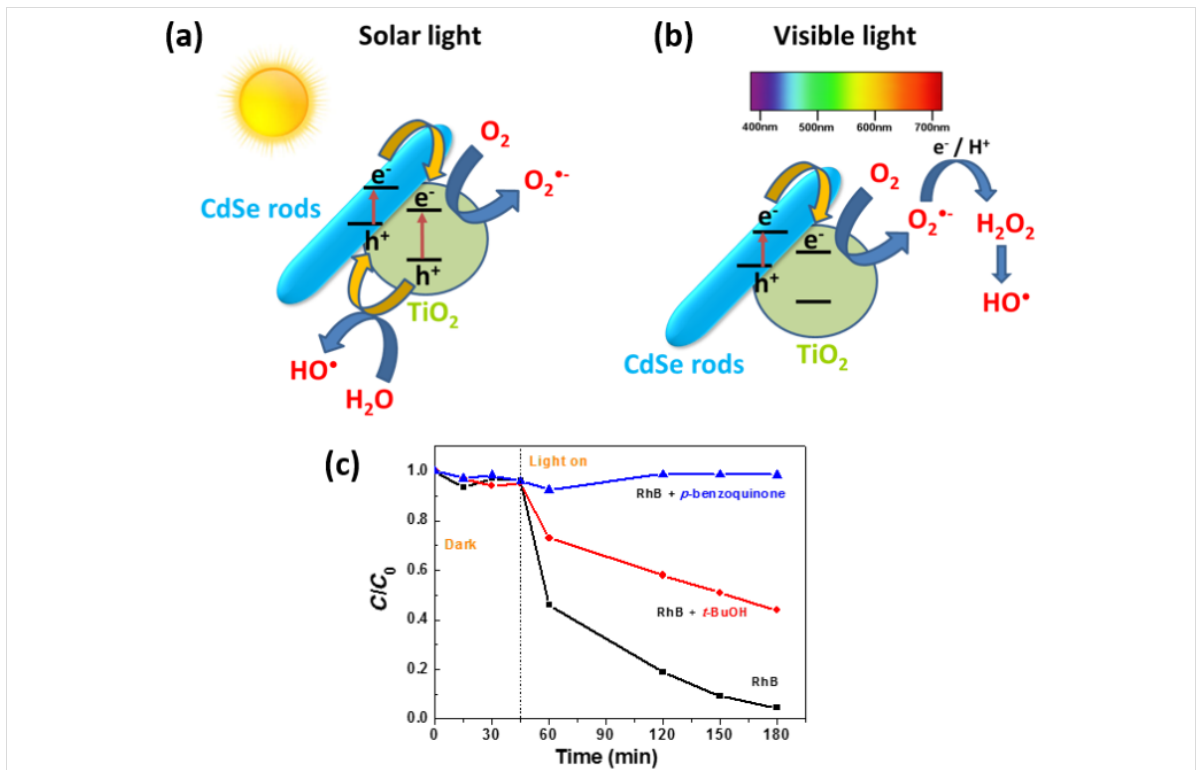
Figure 11: Schematic of the charge separation in the CdSe/TiO 2 photocatalyst under (a) solar light and (b) visible light irradiation. (c) The influence of O 2• − and • OH scavengers on the photocatalytic degradation of rhodamine B under visible light irradiation ( p -benzoquinone and t -BuOH were used at concentrations of 1 mM and 10 mM,